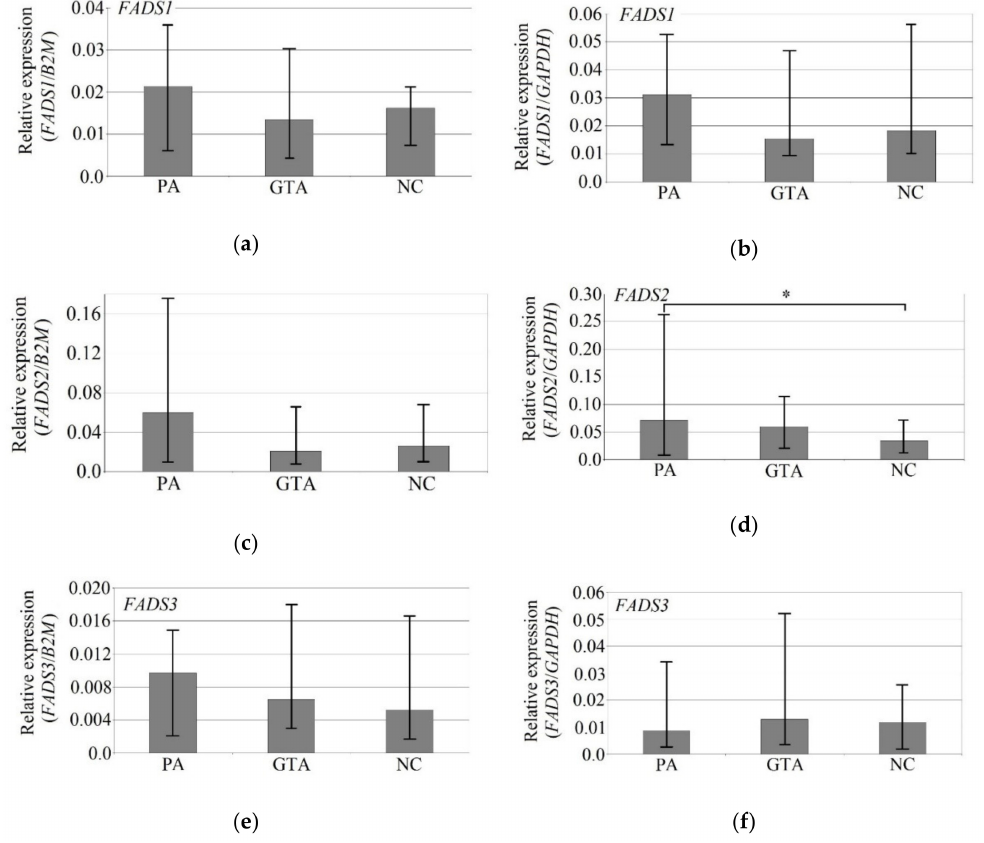
Figure 3. mRNA expression of FADS1 ( a , b ), FADS2 ( c , d ), and FADS3 ( e , f ) depending on the location in GBM, using B2M and GAPDH genes as reference. The graphs show the median mRNA expression of a given desaturase. The error bars are the first and third quartiles. *—statistically significant di ff erence in the expression of a given desaturase between the tumor area according to the Wilcoxon signed-rank test ( p < 0.05). PA—peritumoral area (n = 22); GTA—growing tumor area (n = 19); NC—necrotic core (n =